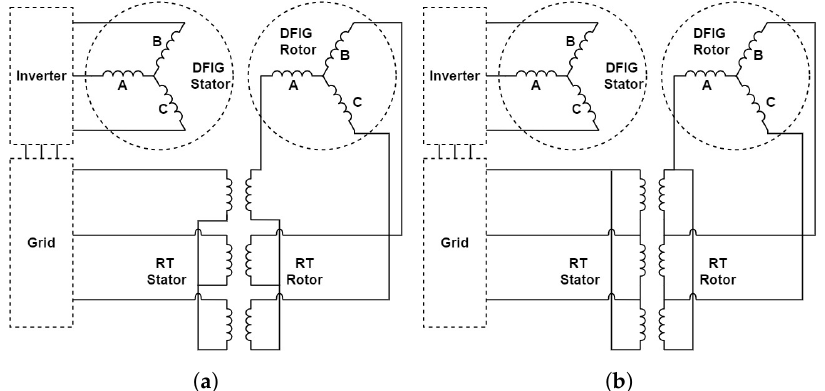
Figure 5. Winding connection diagrams of a three-phase rotary transformer coupled to the rotor of a rotor-tied DFIG in the ( a ) Y–Y and ( b ) ∆ – ∆ configurations.